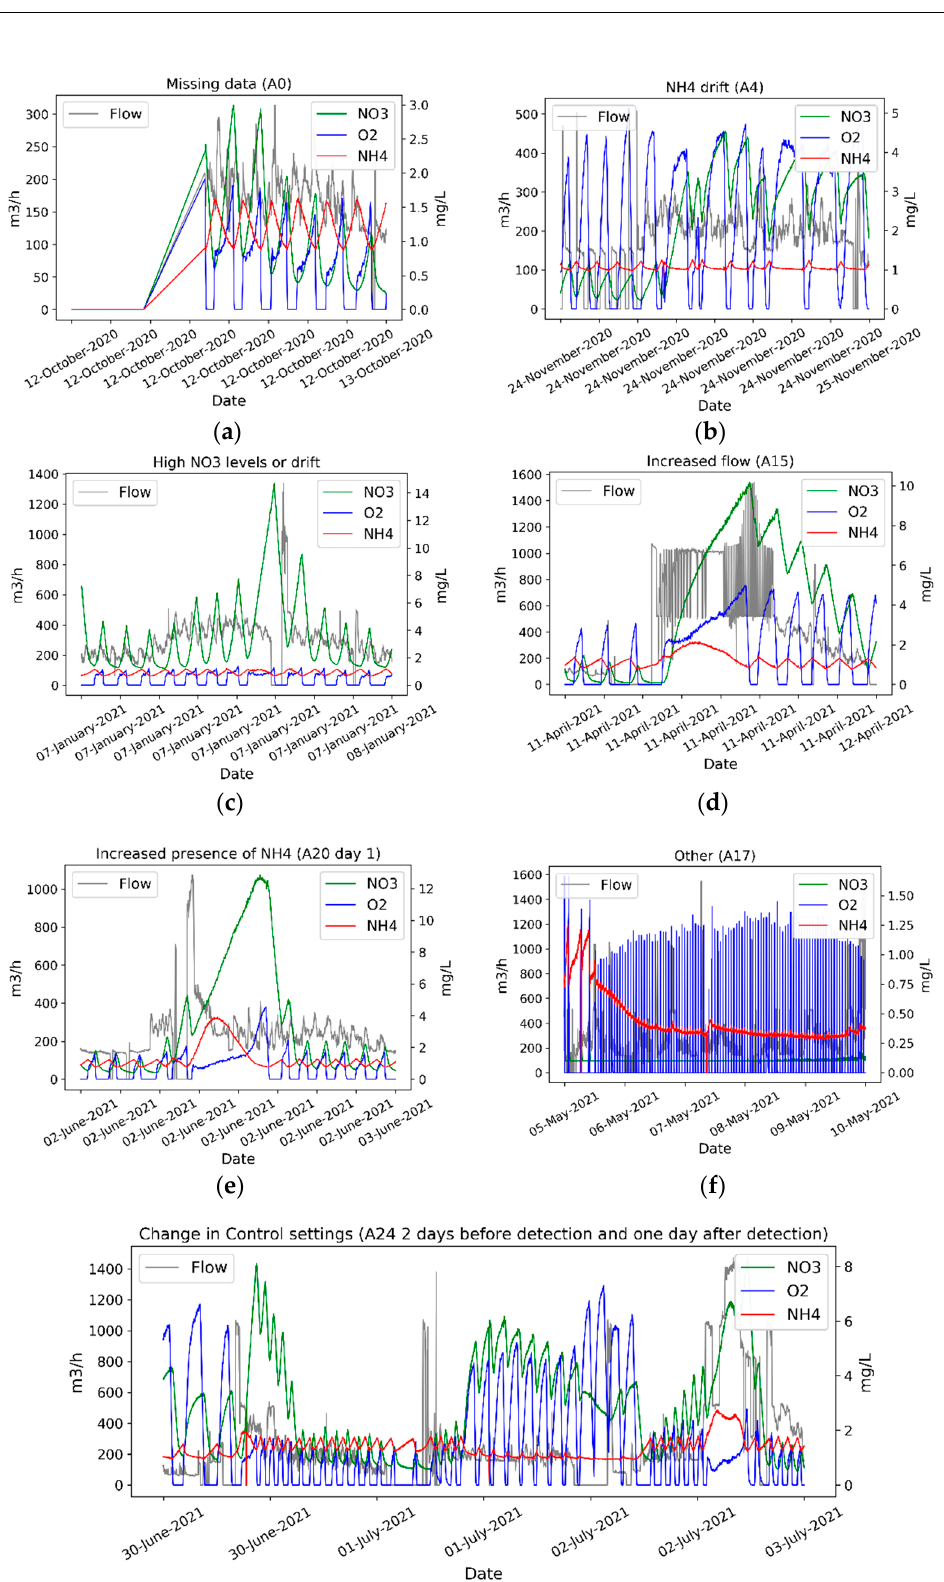
Figure 4. Examples of anomalies detected in WWTP2 PCT1. ( a ) missing data (W2P1A0), ( b ) NH 4 drift (W2P1A4), ( c ) High NO 3 levels or drift, ( d ) Increased flow (W2P1A15), ( e ) Increased presence of NH 4 , ( f ) Other (W2P1A17), ( g ) Change in control settings (two days before onset of W2P1A24 until 1 day after detection).